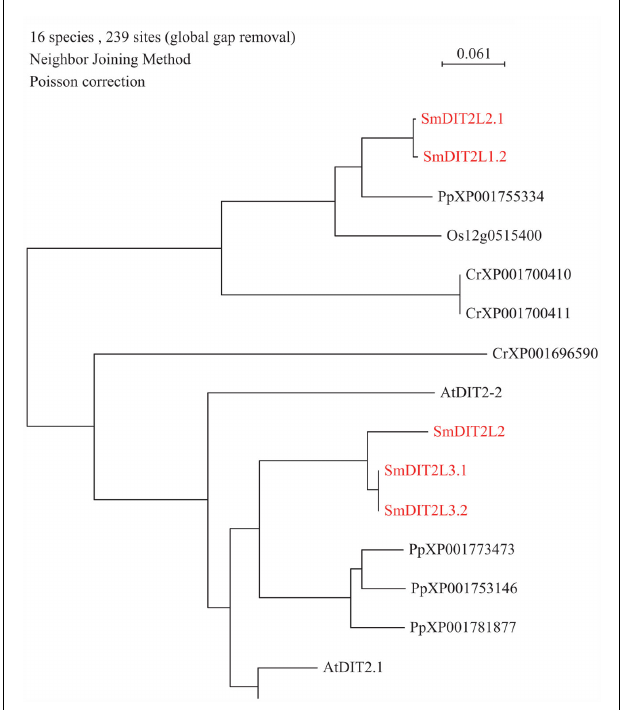
FIGURE 2 | Phylogenetic tree of DiT2 (dicarboxylate) transporter family. The alignment was obtained from ClustalW and tree was build using PAUP software. At, Arabidopsis thaliana ; Cr, Chlamydomonas reinhardtii ; Os, Oryza sativa ; Pp, Physcomitrella patens ; Sm, Selaginella moellendorffii. Red letters indicate a Selaginella moellendorffii